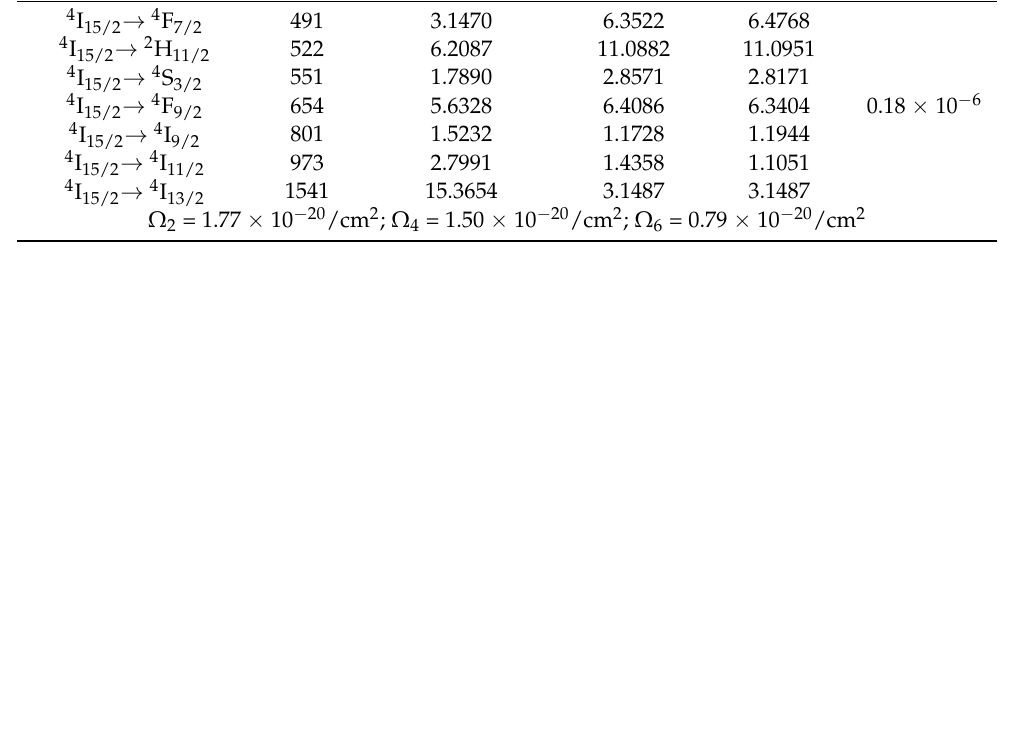
Table 3. fcal, fexp, δ rsm and Ω t ( t = 2, 4 and 6) of Er 3+ in the PMN-32PT:Er 3+ crystal. S (cid:48) L (cid:48) J